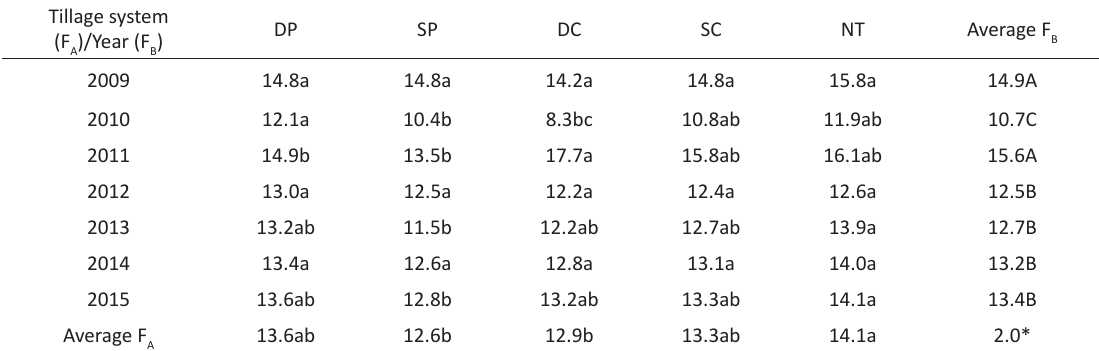
Table 7. The impact of the tillage systems on maize cob lengths (cm) Tillage system